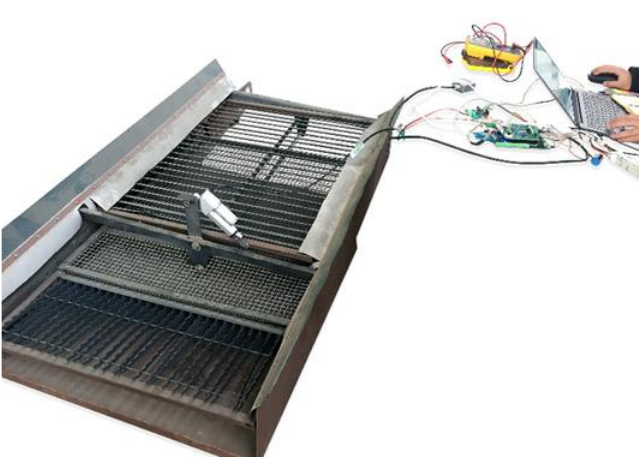
Figure 9. Picture of the test bench.